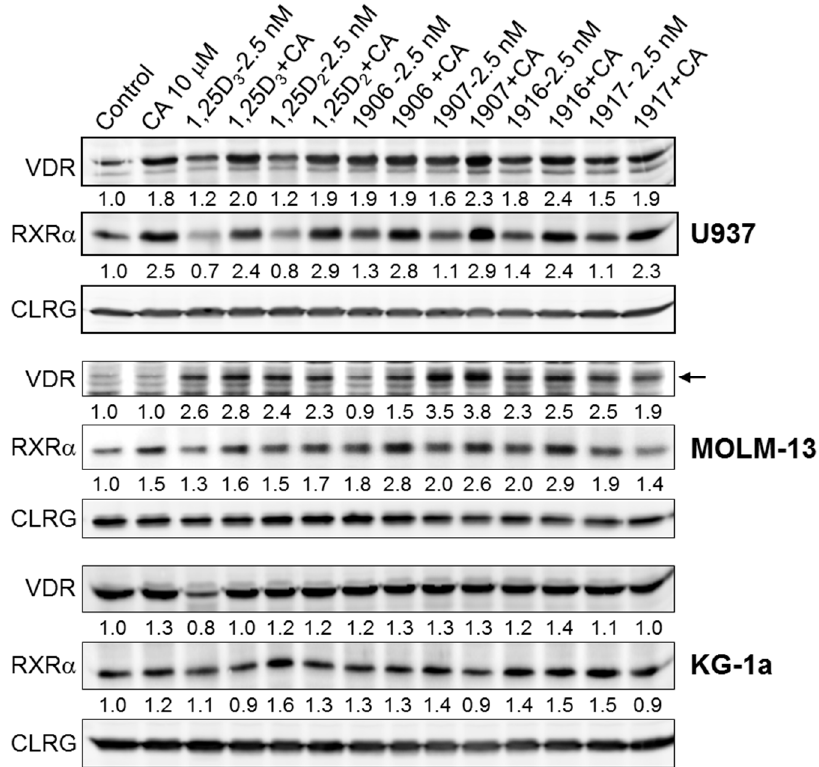
Figure 7. VDDs and CA cooperate in increasing the protein levels of VDR and RXR α in U937 and MOLM-13 cells, but not in KG-1a cells. A Western blot assay was performed following cell treatment with the indicated concentrations of CA and VDDs, alone and in combination, for 48 h. Calregulin (CLRG) was used as the protein loading control. Absorbance values for VDR and RXR α , normalized to those of CLRG, are displayed under each protein band relative to control values. Representatives of 3 similar experiments are shown.